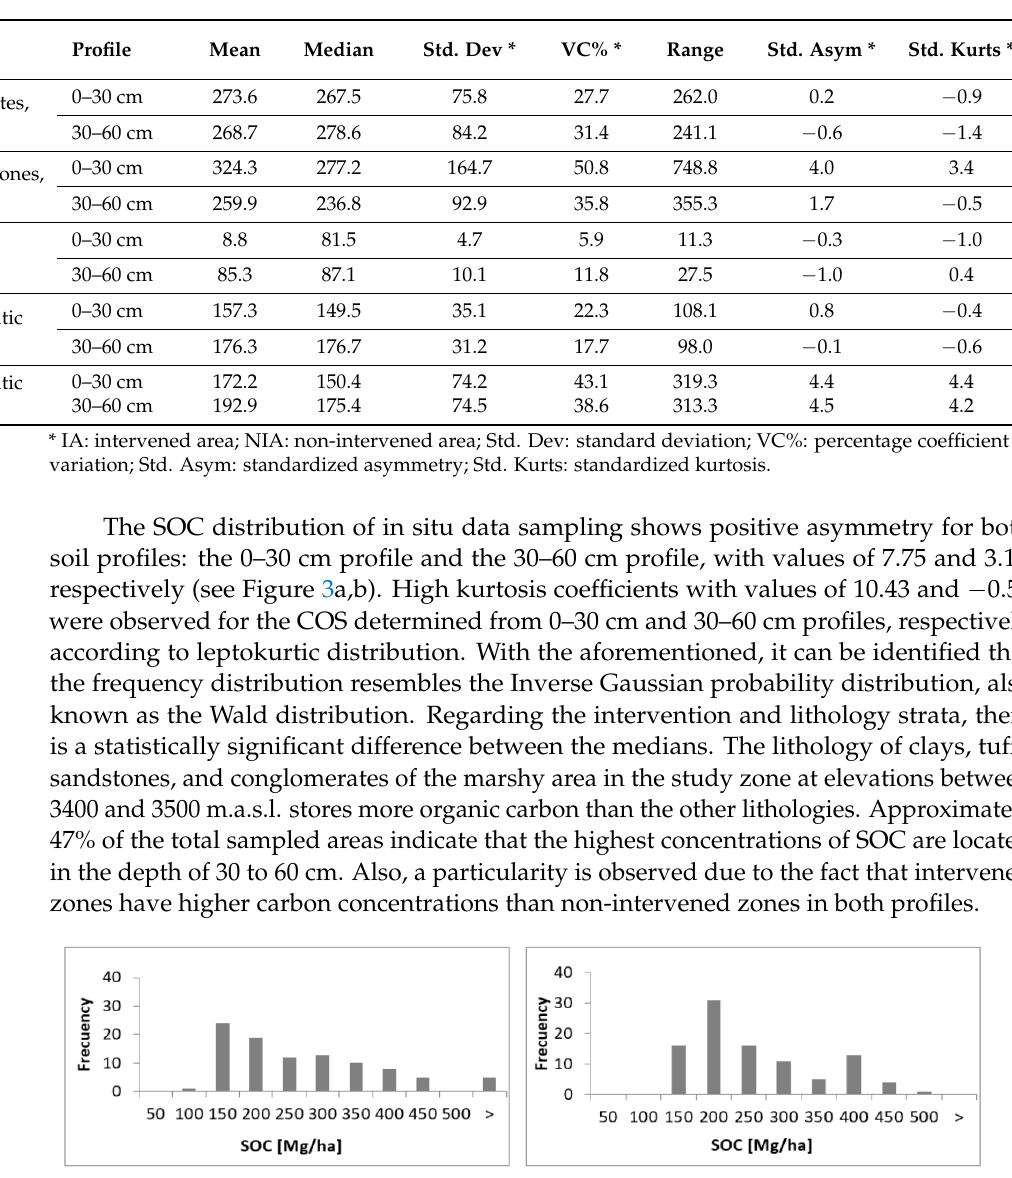
Table 1. Statistic descriptive of SOC in Mg/ha for each lithology of the Atillo River micro-watershed.